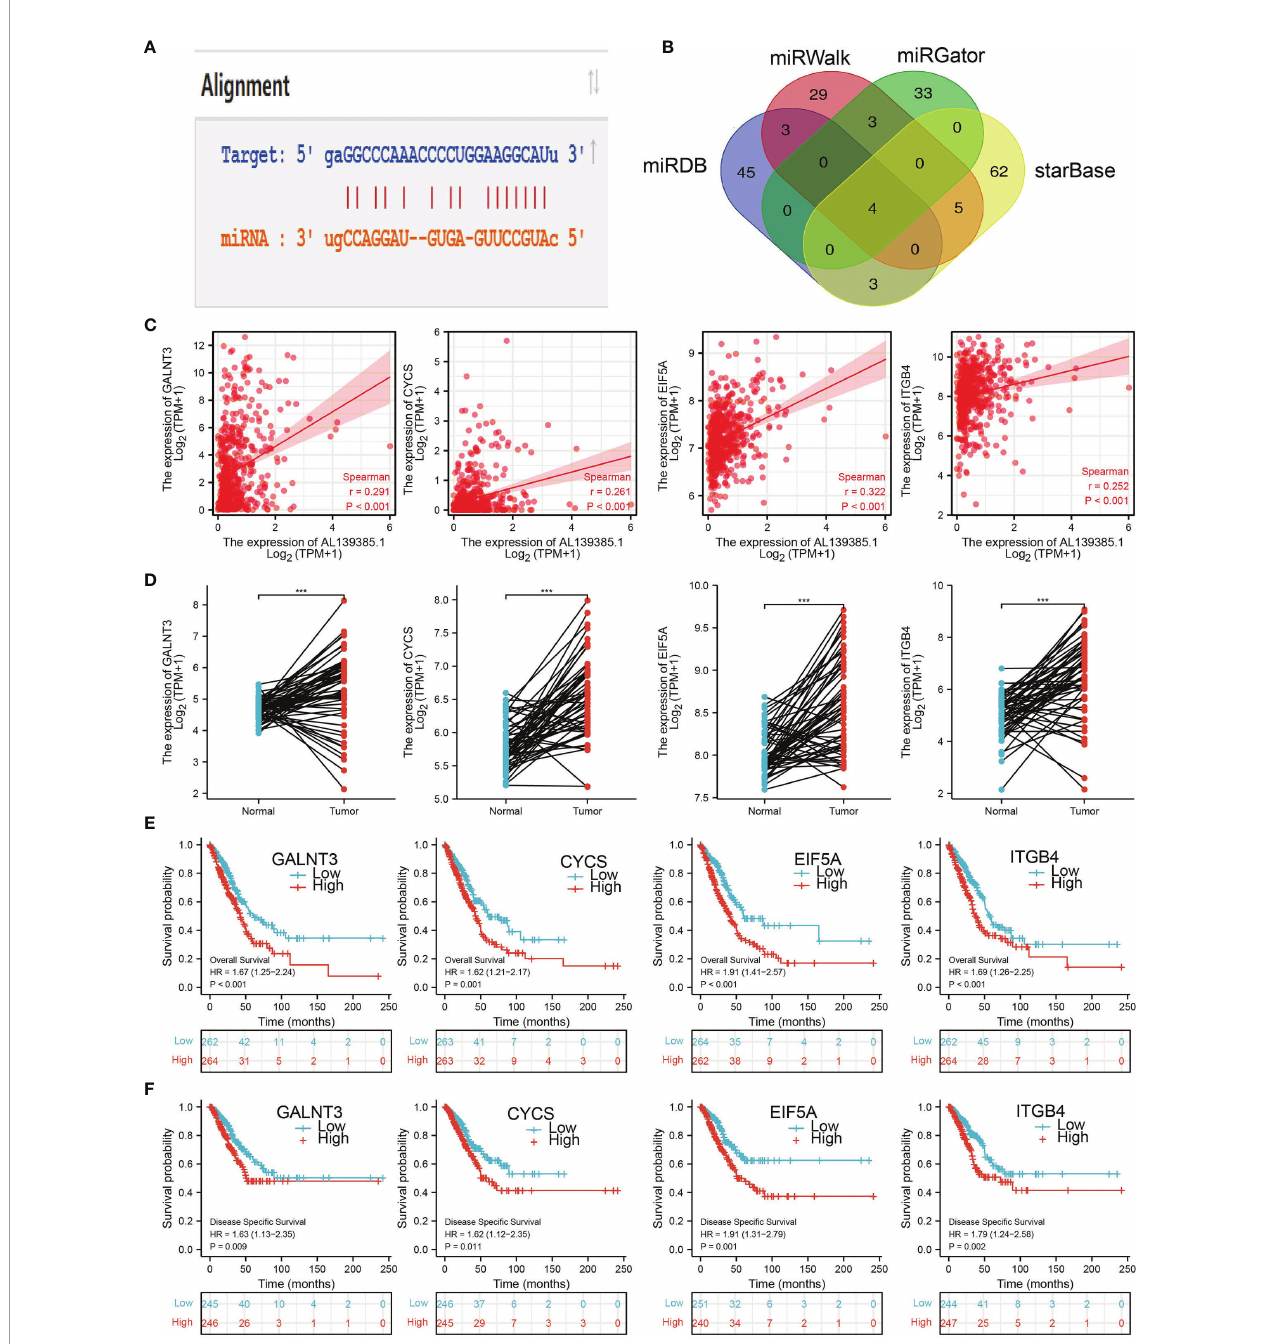
FIGURE 8 | Analysis of the potential mRNAs of AL139385.1/miR-532-5p. (A) Sequence match between miR-532-5p and AL139385.1. (B) Identifying GALNT3, CYCS, EIF5A, and ITGB4 as the downstream target of miRNA-532-5p using various datasets. (C) Correlations between AL139385.1 expression and GALNT3, CYCS, EIF5A, and ITGB4 in LUAD. (D) The expression level of GALNT3, CYCS, EIF5A, and ITGB4 in LUAD. (E, F) The overall survival and disease-free survival of GALNT3, CYCS, EIF5A, and ITGB4 in LUAD.